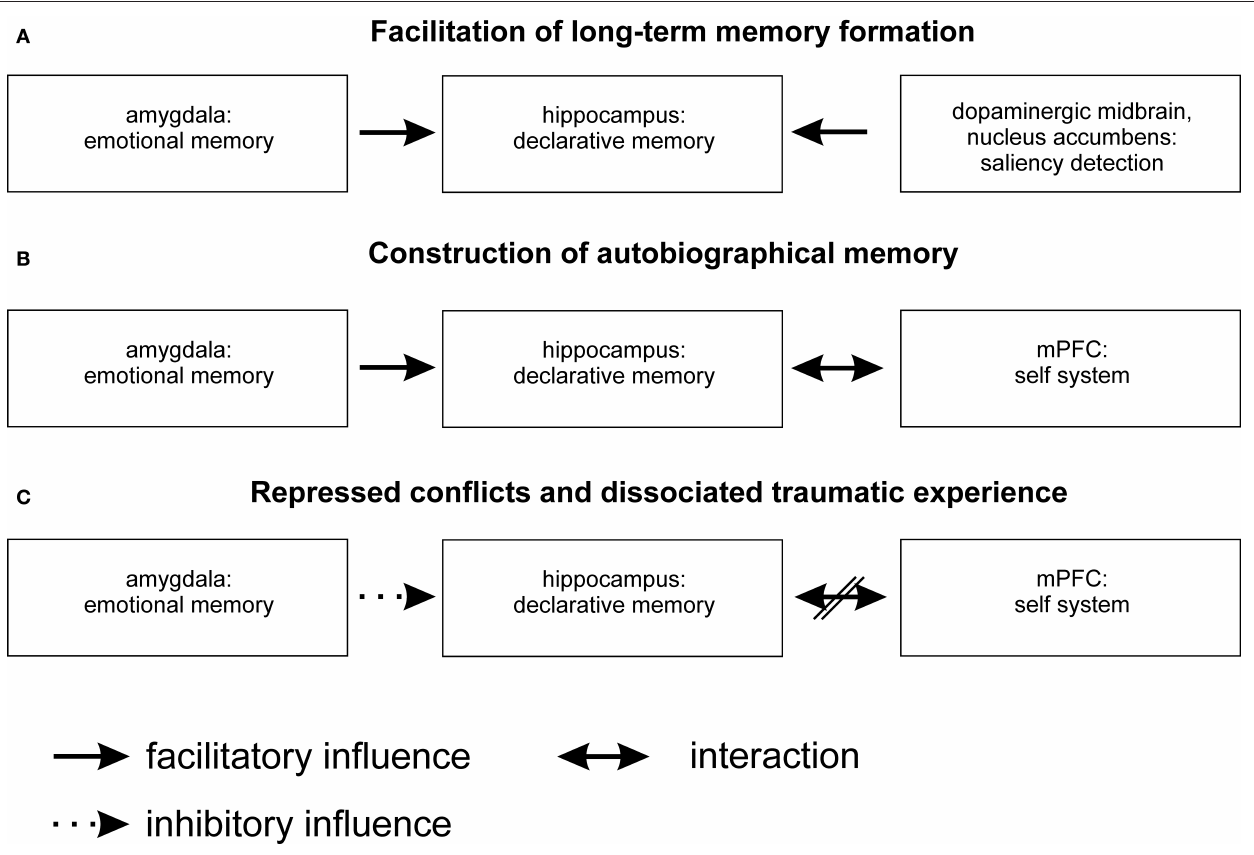
(mPFC). This process is facilitated by (moderately) emotional events due to inputs from the amygdala. (C) In contrast, in the case of extremely negative (conflictual or traumatic) experiences, the amygdala inhibits declarative memory formation by the hippocampus and an integration of these memories with the